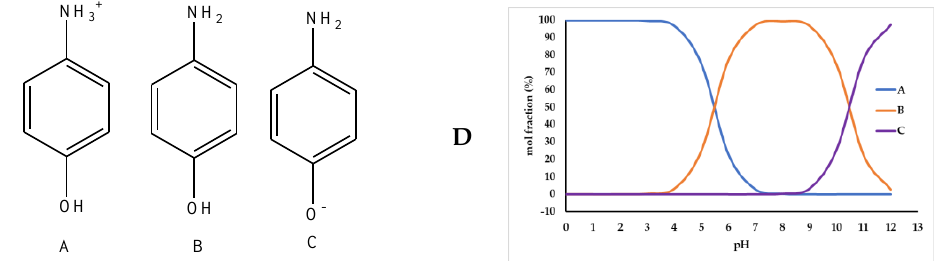
Figure 8. Structure of p -AP at pH < pK a1 ( A ); pK a1 < pH < pK a2 ( B ); pH > pK a2 ( C ) and mole fractions of A, B, and C ( D ).